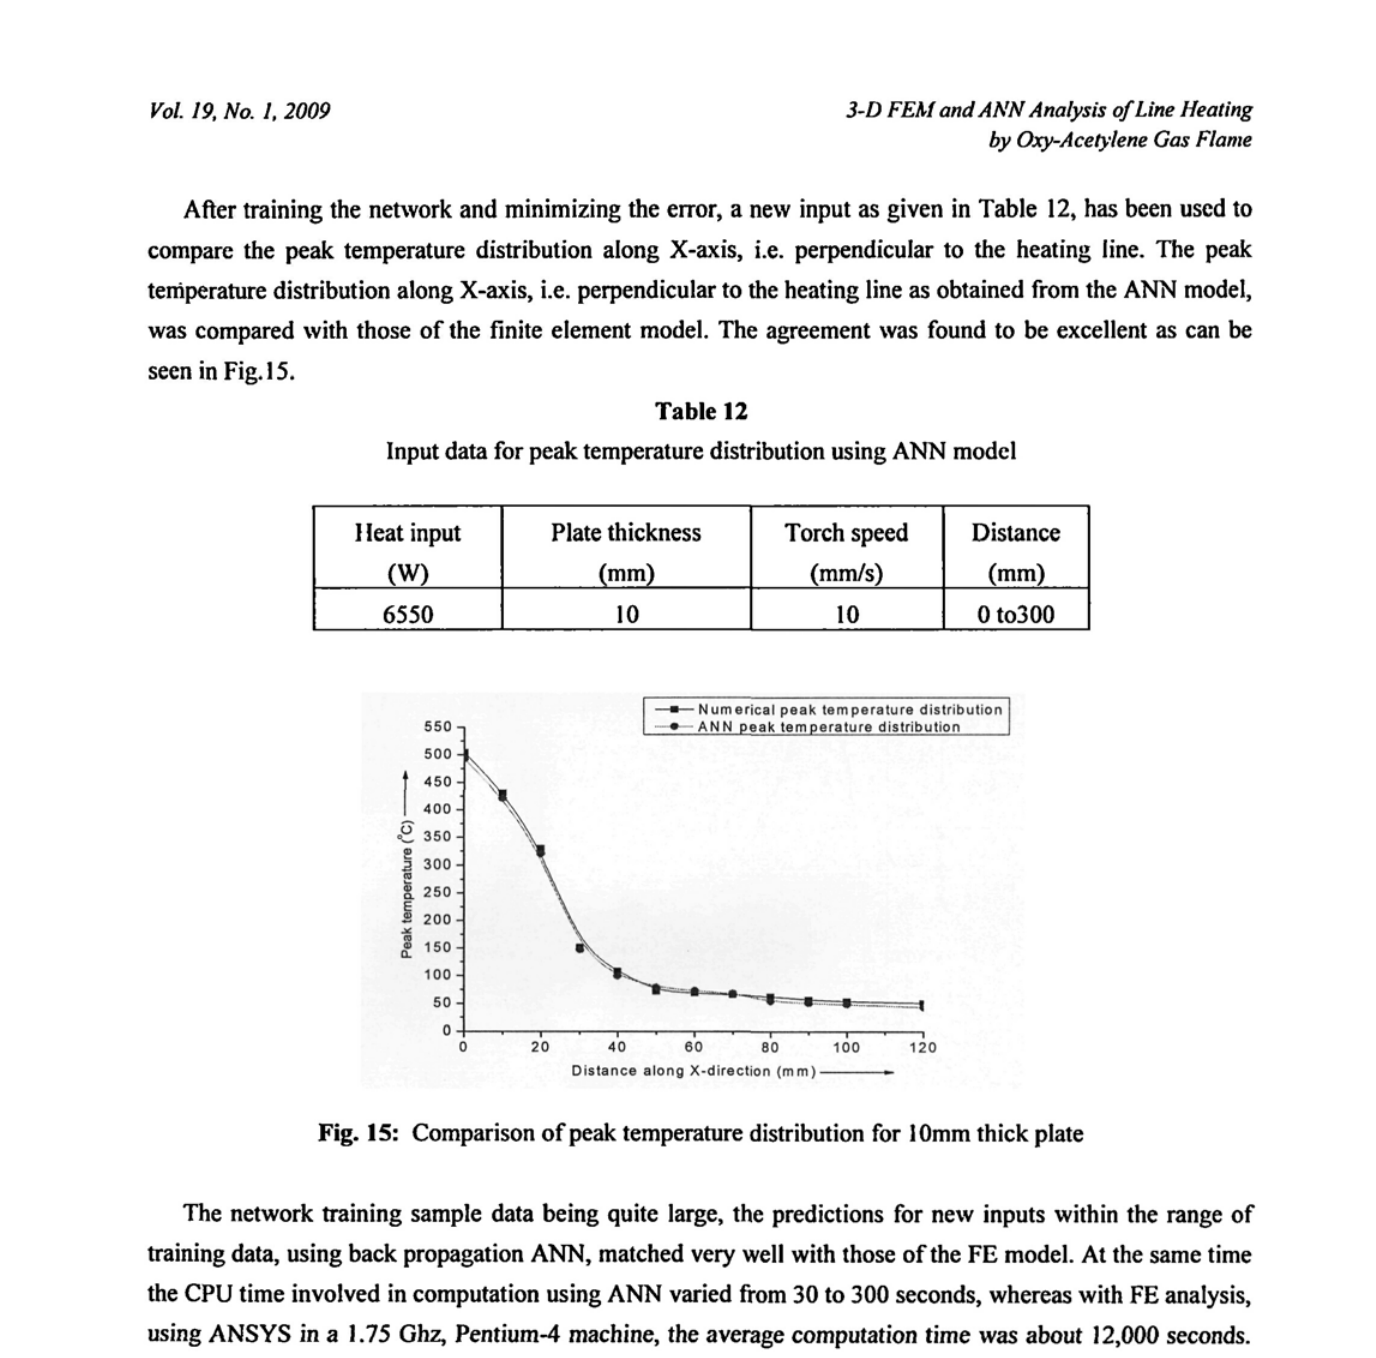
Fig. 15: Comparison of peak temperature distribution for 10mm thick